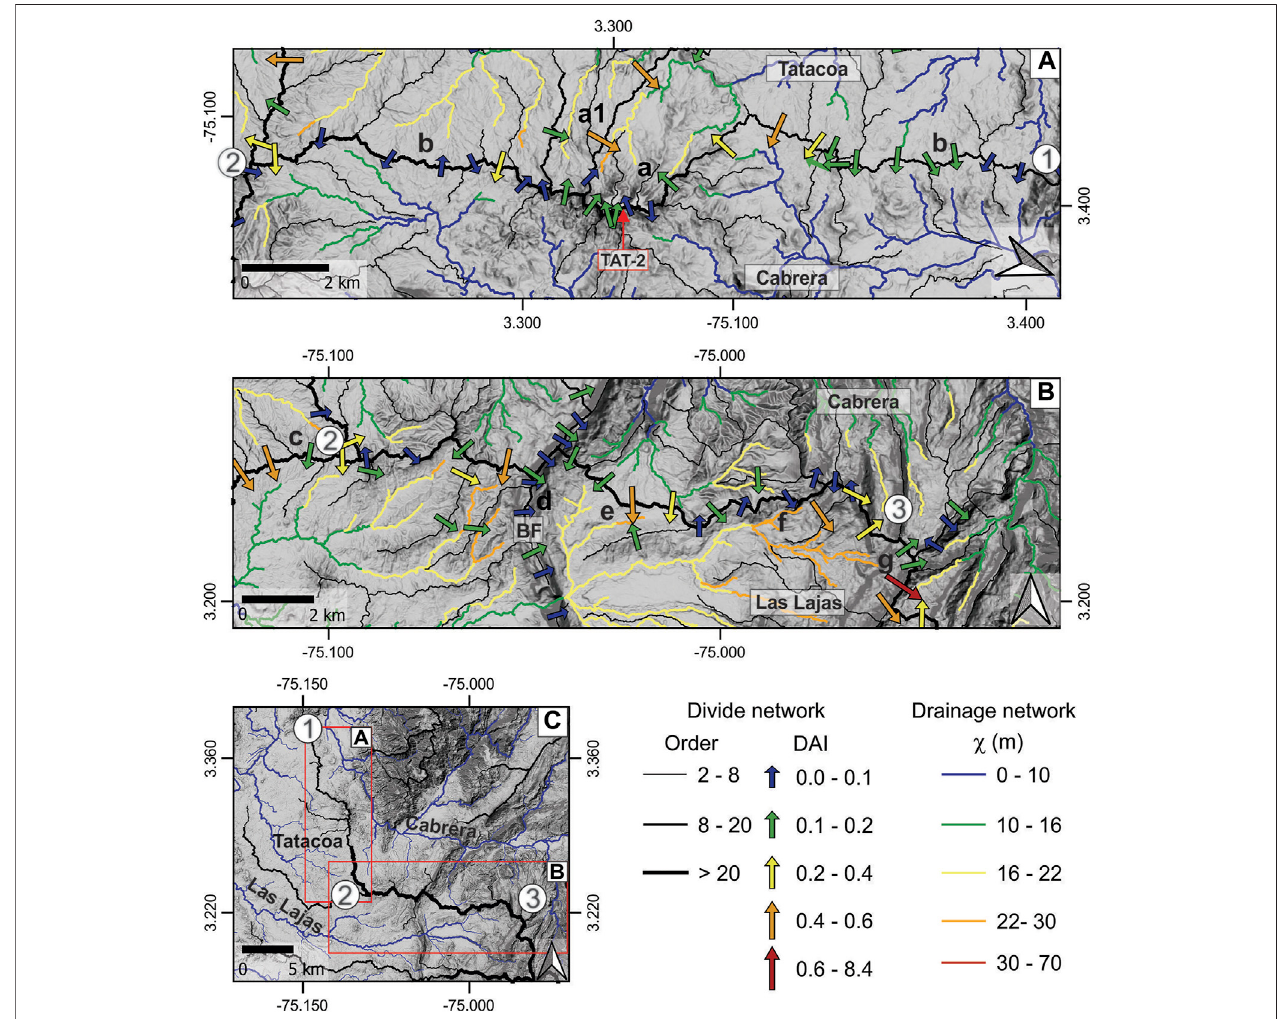
FIGURE 8 | Across-divide metrics in the drainage divide between the Cabrera catchment and the Tatacoa drainage system (A) and between the Cabrera and the LasLajas catchments (B) Itisnotedthat (A) isrotated110 ° clockwise. BFistheBaraya Fault.Thesmallletters arereferencepositionstofollowthediscussionalongwith thetext.Themetricsarethedivideasymmetryindex(DAI),forthedividenetwork;andthe χ -valuesforthedrainagenetwork.Thearrowspointtowardthedividemigration (fromthehigherreliefsideintothelowerone). (C) Therelativepositionofthedividesandmainrivers;thedividenetworkistheblackline,andthedrainagenetworkis the blue lines. The numbers are reference points to locate the divide position in (A,B)